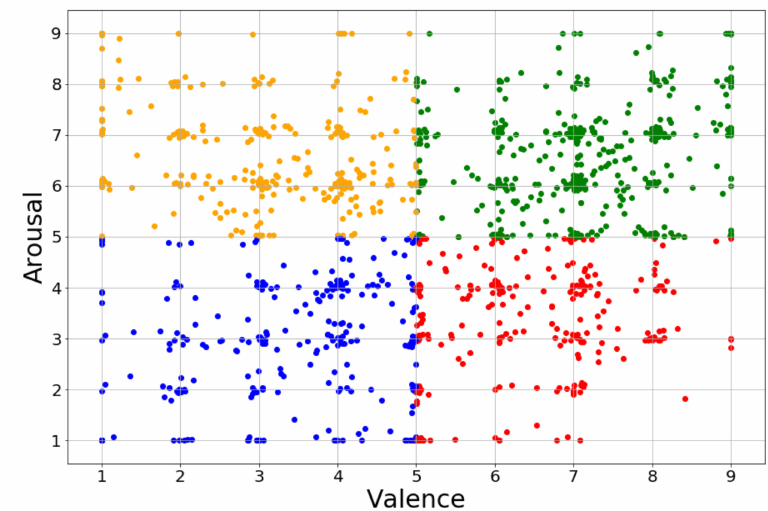
Figure 3. The scatter plot of rating values high valence high arousal (HVHA; green), high valence low arousal (HVLA; red), low valence high arousal (LVHA; yellow), and low valence low arousal (LVLA; blue) in the DEAP.